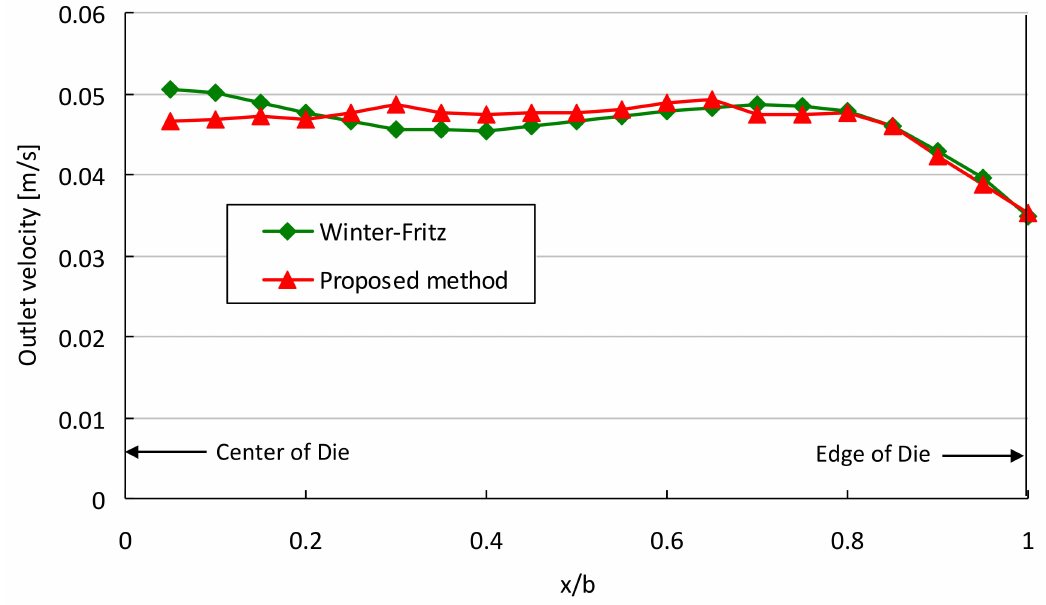
Figure 12. Comparison of velocity distribution obtained from CFD at the slit exit of die for a power-law fluid with W/b =